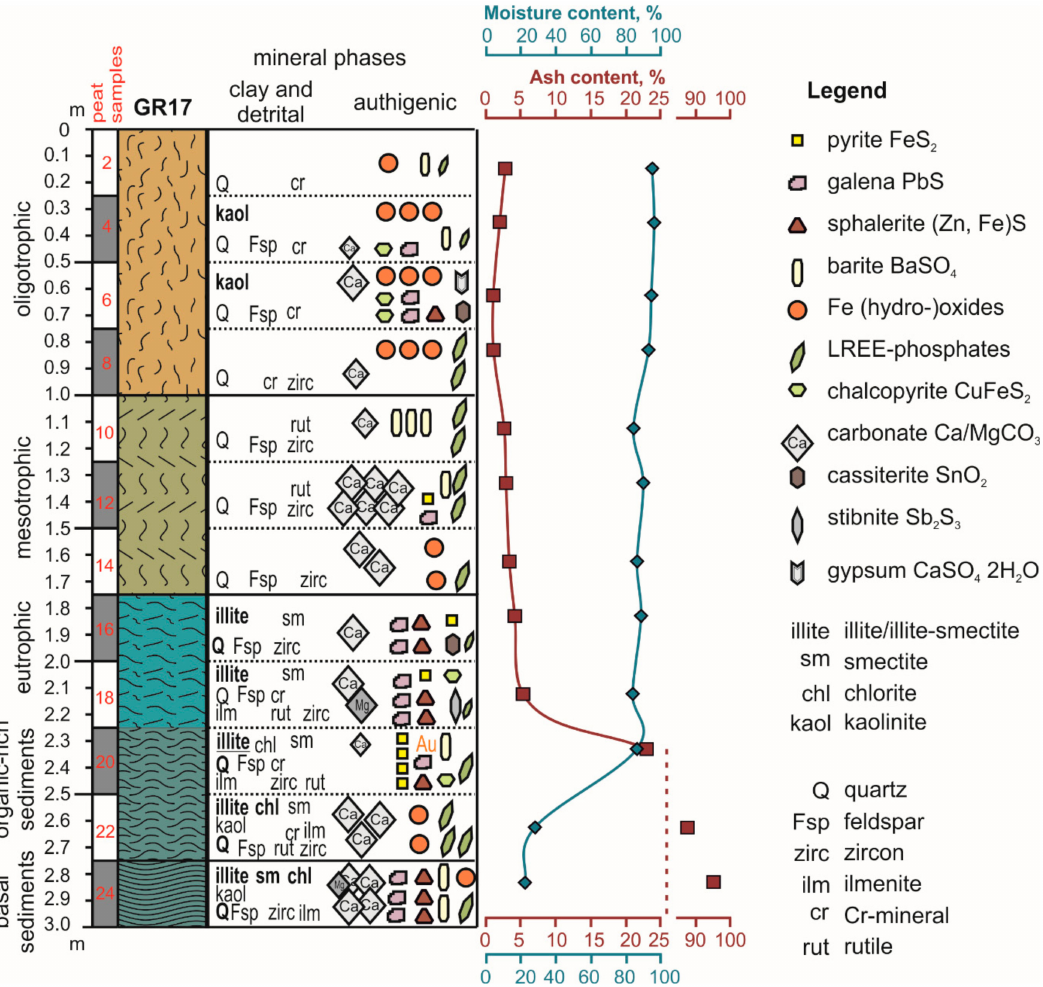
Figure 2. Bulk mineral composition in inorganic fraction, ash, and moisture content (%) of peat and basal sediments. Oligotrophic peat (0–1 m) consists of Sphagnum fuscum , mesotrophic peat (up to 1.75–1.8 m) depth is comprised of Sphagnum magellanicum peat, eutrophic peat (1.8–2.25 m) and organic-rich sediment (2.25–2.75 m) consist of Sphagnum jensenii and woody peat, and the basal sediments (from 2.75) are presented by